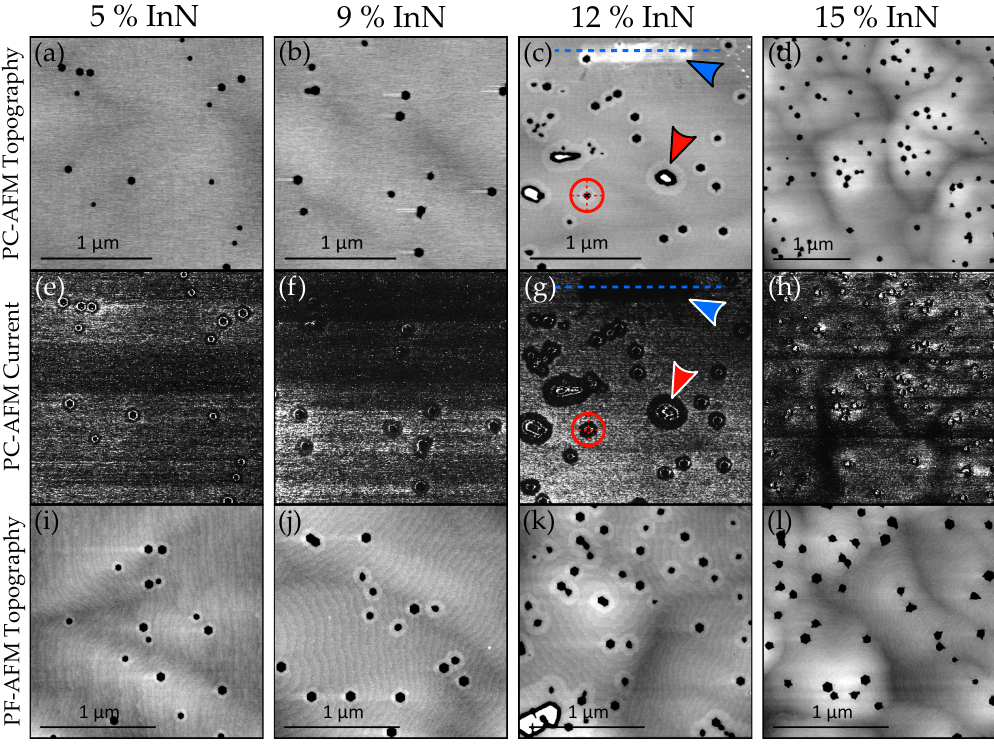
Figure 1. Topography maps obtained from PC-AFM for ( a ) In 0.05 Ga 0.95 N ( ∆ z = 6.5 nm) ( b ) In 0.09 Ga 0.91 N ( ∆ z = 6.0 nm) ( c ) In 0.12 Ga 0.88 N ( ∆ z = 6.0 nm) and ( d ) In 0.15 Ga 0.85 N ( ∆ z = 12.0 nm), along with their corresponding current maps in ( e ) ( ∆ I = 6.0 pA) ( f ) ( ∆ I = 30.0 pA) ( g ) ( ∆ I = 250.0 pA) and ( h ) ( ∆ I = 30.0 pA), all obtained under illumination. Blue arrows highlight the presence of an insulating layer, while red arrows indicate an example of a defect ridge. Applied bias was +5.5 V for In 0.05 Ga 0.95 N, and +4.5 V for all other samples. PF-AFM topography maps for each sample are given in ( i ) ( ∆ z = 3.5 nm) ( j ) ( ∆ z = 3.0 nm) ( k ) ( ∆ z = 4.5 nm) and ( l ) ( ∆ z = 6.0